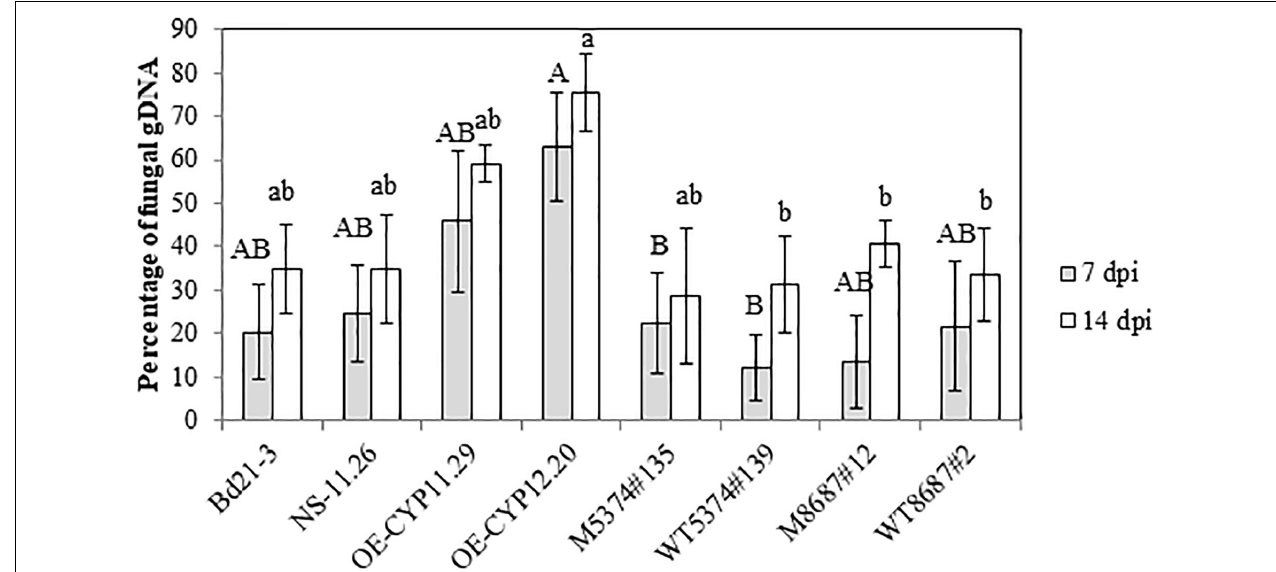
FIGURE 7 | Overexpression of the BdCYP711A29 gene promotes F. graminearum development on B. distachyon spikes following spray inoculation. Relative quantification of fungal DNA by qPCR compared to total DNA 7 and 14 days after spray inoculation of different B. distachyon lines with the FgDON + strain of F. graminearum . Mean of three independent biological replicates ± standard error. Different letters indicate significant differences between conditions ( p -value < 0.05, one way ANOVA and pairwise t -tests with Bonferroni correction).